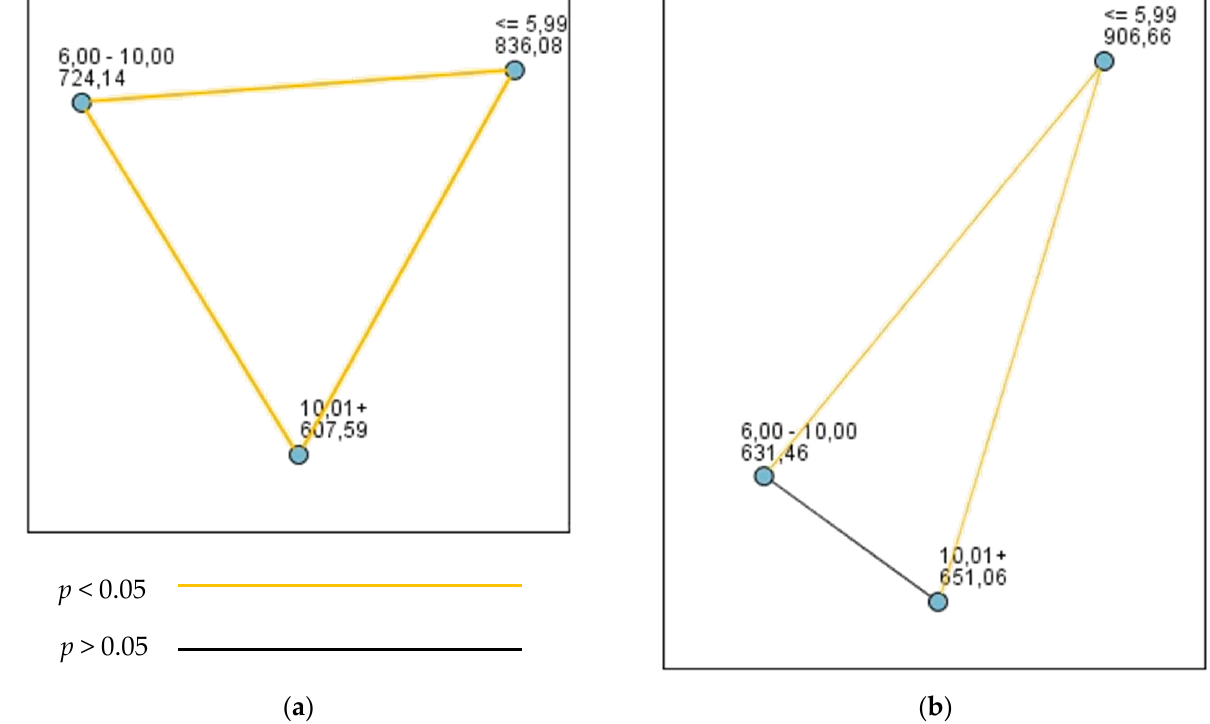
Figure 4. Multiple pairwise comparisons of the PL/min and HR avg variables according to the total task time. Note: eTL = external load; PL = Player Load; iTL = internal load; HR = Heart Rate; min = minute; avg = average. ( a ) eTL (PL/min) and ( b ) iTL (HR avg ).